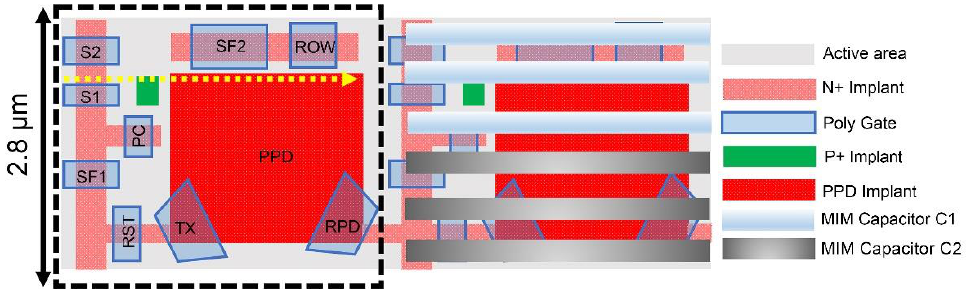
4 of 11 Figure 4. The schematic cross-section of GSI pixel with ( a ) STI and ( b ) merged active area. Figure 5 exhibits the layout of the designed 9T GS pixel. In order to prevent the STI from affecting the dark current performance of the pixel unit, the active area of the entire